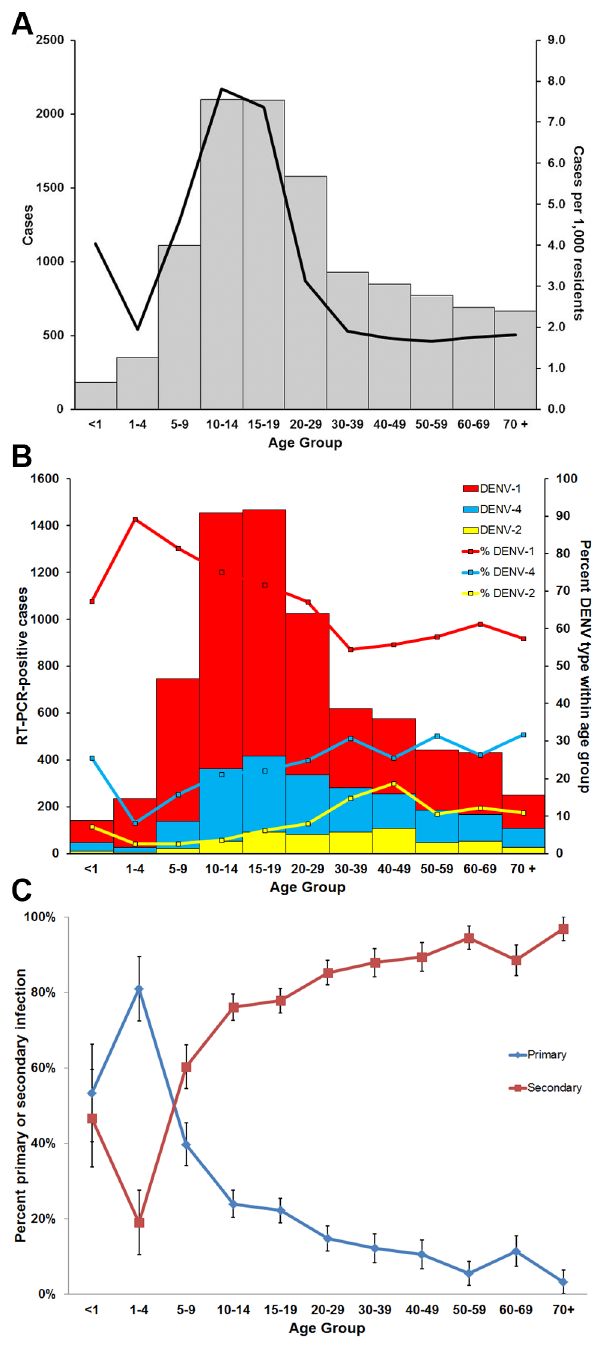
Figure 3. Age distribution of laboratory-positive cases, Puerto Rico, 2010. A : Age distribution and rates of laboratory-positive cases; B : Age distribution and incidence of RT-PCR-positive cases by infecting DENV-type; C : Primary and secondary DENV infections by age group from a representative sample of RT-PCR-positive cases; error bars indicate standard error of the mean; denominators by age group are 15, 21, 73, 146, 162, 115, 74, 66, 54, 61 and 31, respectively.